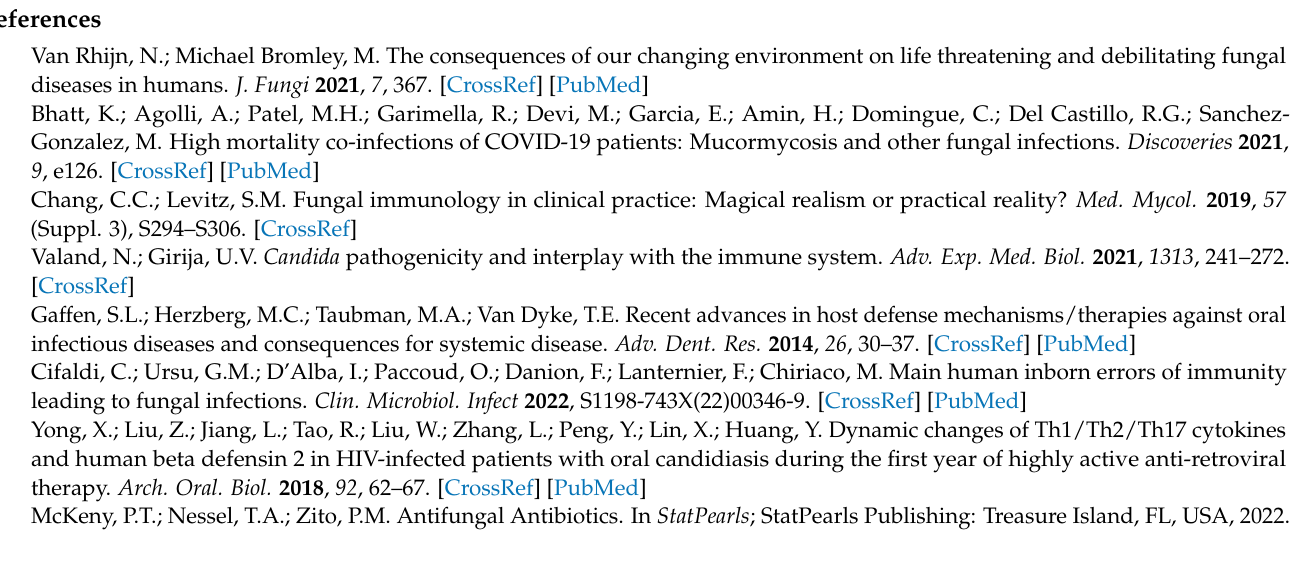
fensins; Figure S2: (A) Comparison of the amino acid sequences of two legumes defensins—lentil Lc-def and pea Psd1. Identical and similar amino acids are shown in green and blue, respectively. %I, percentage of sequence identity. (B) ELISA with lentil Lc-def and pea Psd1 using rabbit poly- clonal anti-Lc-def antibodies. Error bars represent standard deviation between technical replications. (C) SDS-PAGE analysis or (D) immunoblotting with rabbit polyclonal anti-Lc-def antibodies of Lc-def in the absence (1) or present (2) of BME and lysate of E. coli cells (3) expressing the fusion protein 8His-Trxl-Lc-def (MW 19kDa); Figure S3: (A) The growth of the clinical isolate of C. albicans in the presence of different concentrations of lentil lipid transfer protein Lc-LTP2 (100, 50, 25, 12.5, 6.25, 3.125, and 1.56 µ M). Asterisk (red) shows optical density of the control without peptide. (B) Hemolytic assay of different concentrations of Lc-def and melittin as positive control. Error bars represent standard deviation between technical replications; Figure S4: (A) Effect of heating on the sensitivity of Lc-def to digestive enzymes as detected by means of RP-HPLC on Luna C 18 column (5 µ m, 250 × 4.6 mm; Phenomenex) at a flow rate of 0.5 mL/min, using a linear gradient of acetonitrile concentration from 5 to 80% for 60 min in 0.1% trifluoroacetic acid (0 ‘ and 120 (cid:48) p—pepsin digestion during 10 s and 120 min; 120 (cid:48) and 24 h p+ch—subsequent digestion by mixture trypsin/ α -chymotrypsin during 120 min and 24 h). (B) MALDI mass spectra of the RP-HPLC fractions (from 28, 31, and 33 min) of Lc-def digests; Table S1: List of overlapping primers; Table S2: Absolute levels of 48 cytokines, chemokines, and growth factors assessed by multiplex xMAP technology. Values highlighted in black indicate that the data fall below the low detectable limit, while in blue indicate that the data are in the detectable range; C corresponds to control